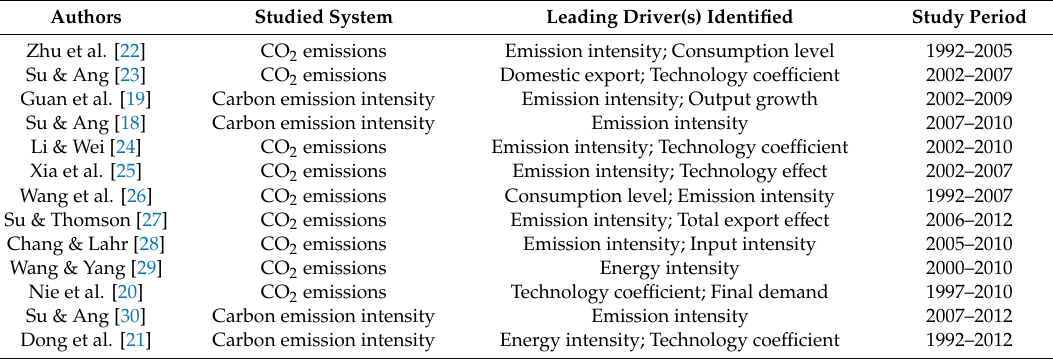
Table 1. Recent studies on drivers of CO 2 emissions and emissions intensity in China via structural decomposition analysis